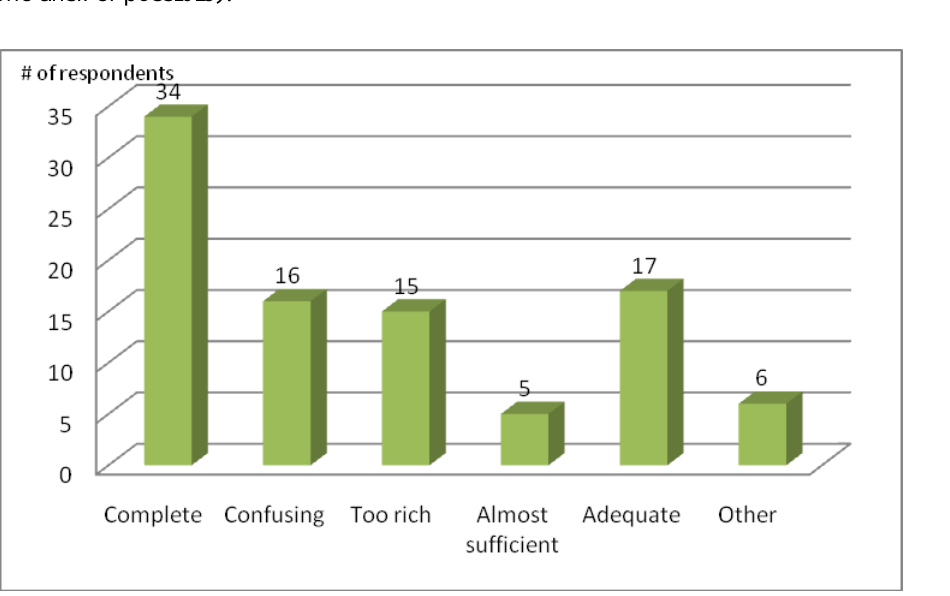
Figure 6 . Opinions on the course